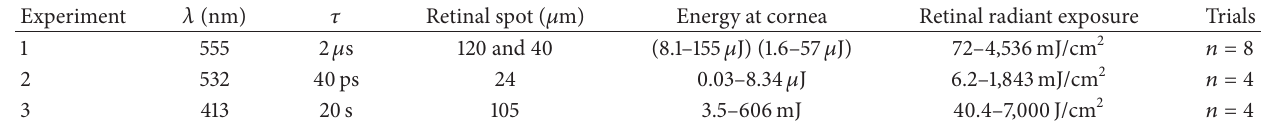
Table 1: Summary of exposure parameters.